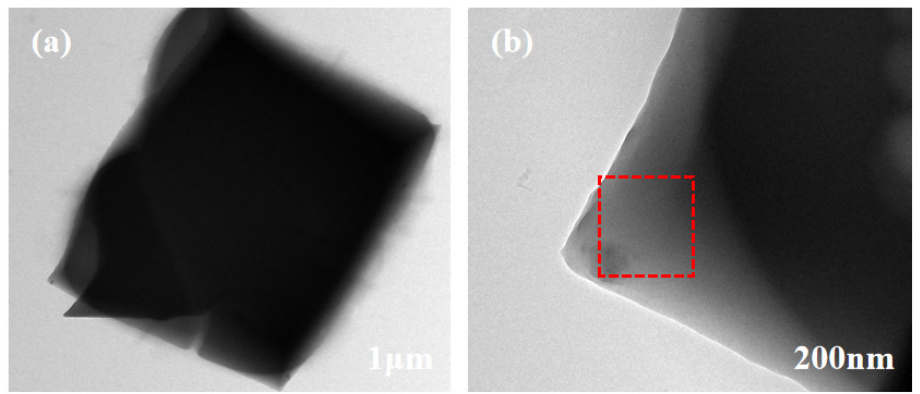
Figure 8. HR-TEM images of tannins ( a , b Figure 8. HR − TEM images of tannins ( a , b ). Figure 8. HR − TEM images of tannins ( a , b ).